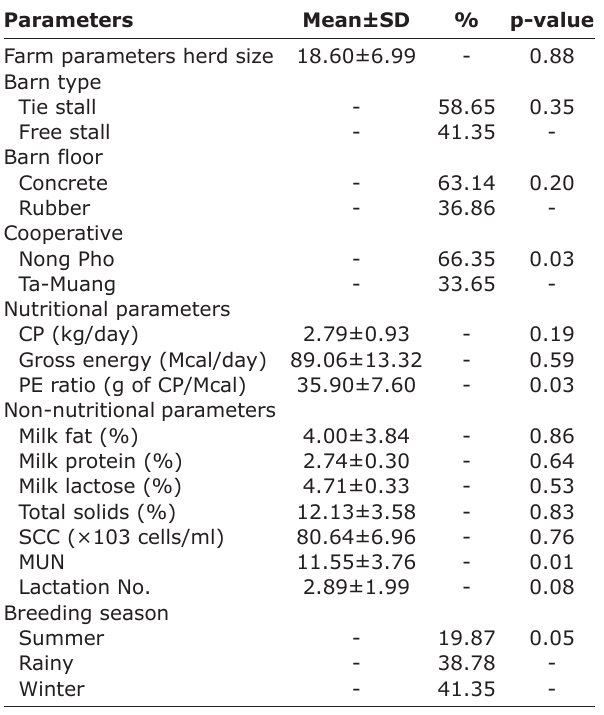
Table-1: Descriptive statistics of parameters analyzed by unconditional univariable logistic regression for associations with first service conception (p-value), among 295 cows on 43 smallholder dairy farms in Thailand in 2014-2015.